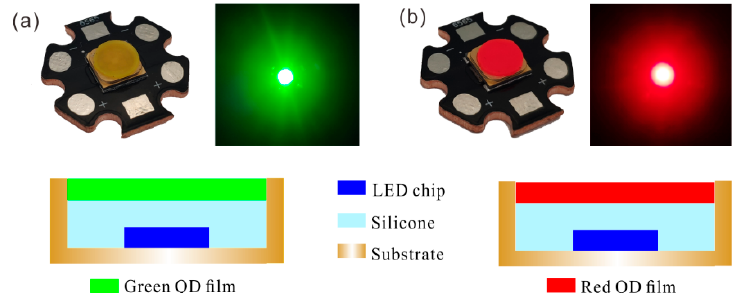
Figure 3. Physical picture and schematic diagram of ( a ) green quantum-dot LED and ( b ) red quantum-dot LED.